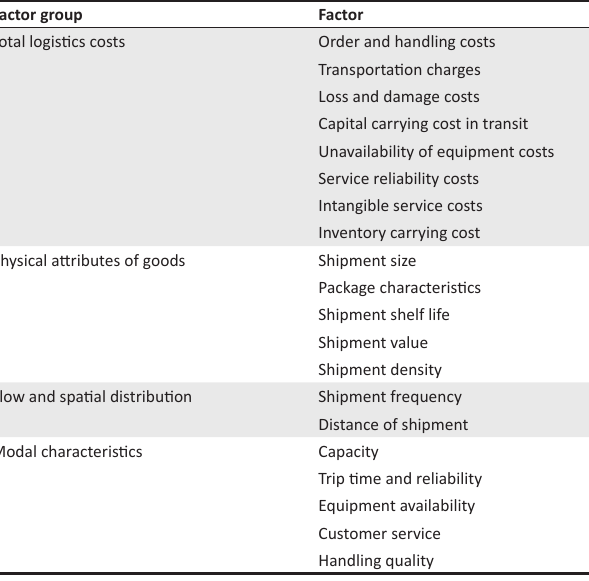
TABLE 1: Factors that affect freight modal choice. Factor group